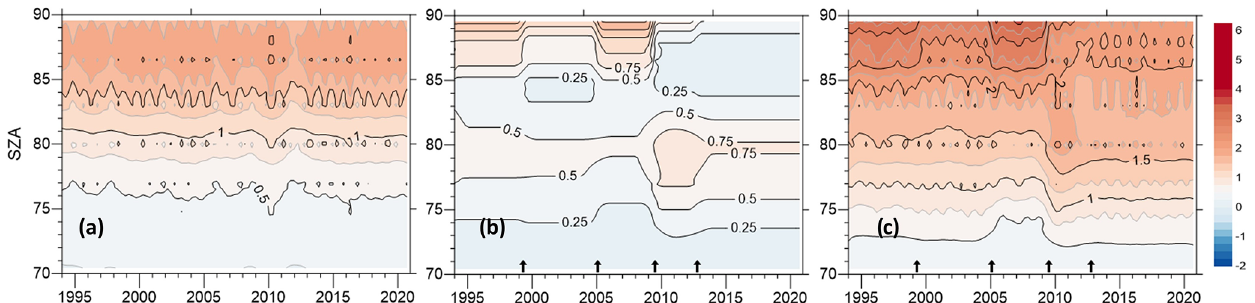
Figure 3. Plots show the time-series of Umkehr N -value corrections in Boulder: (a) standardized stray light (SLC) corrections, (b) the optimized (OPT) stray light correction, and (c) final optimization applied by combining SLC and OPT corrections. Black arrows at the bottom of panels (b) and (c) indicate dates of Umkehr record corrections (Table